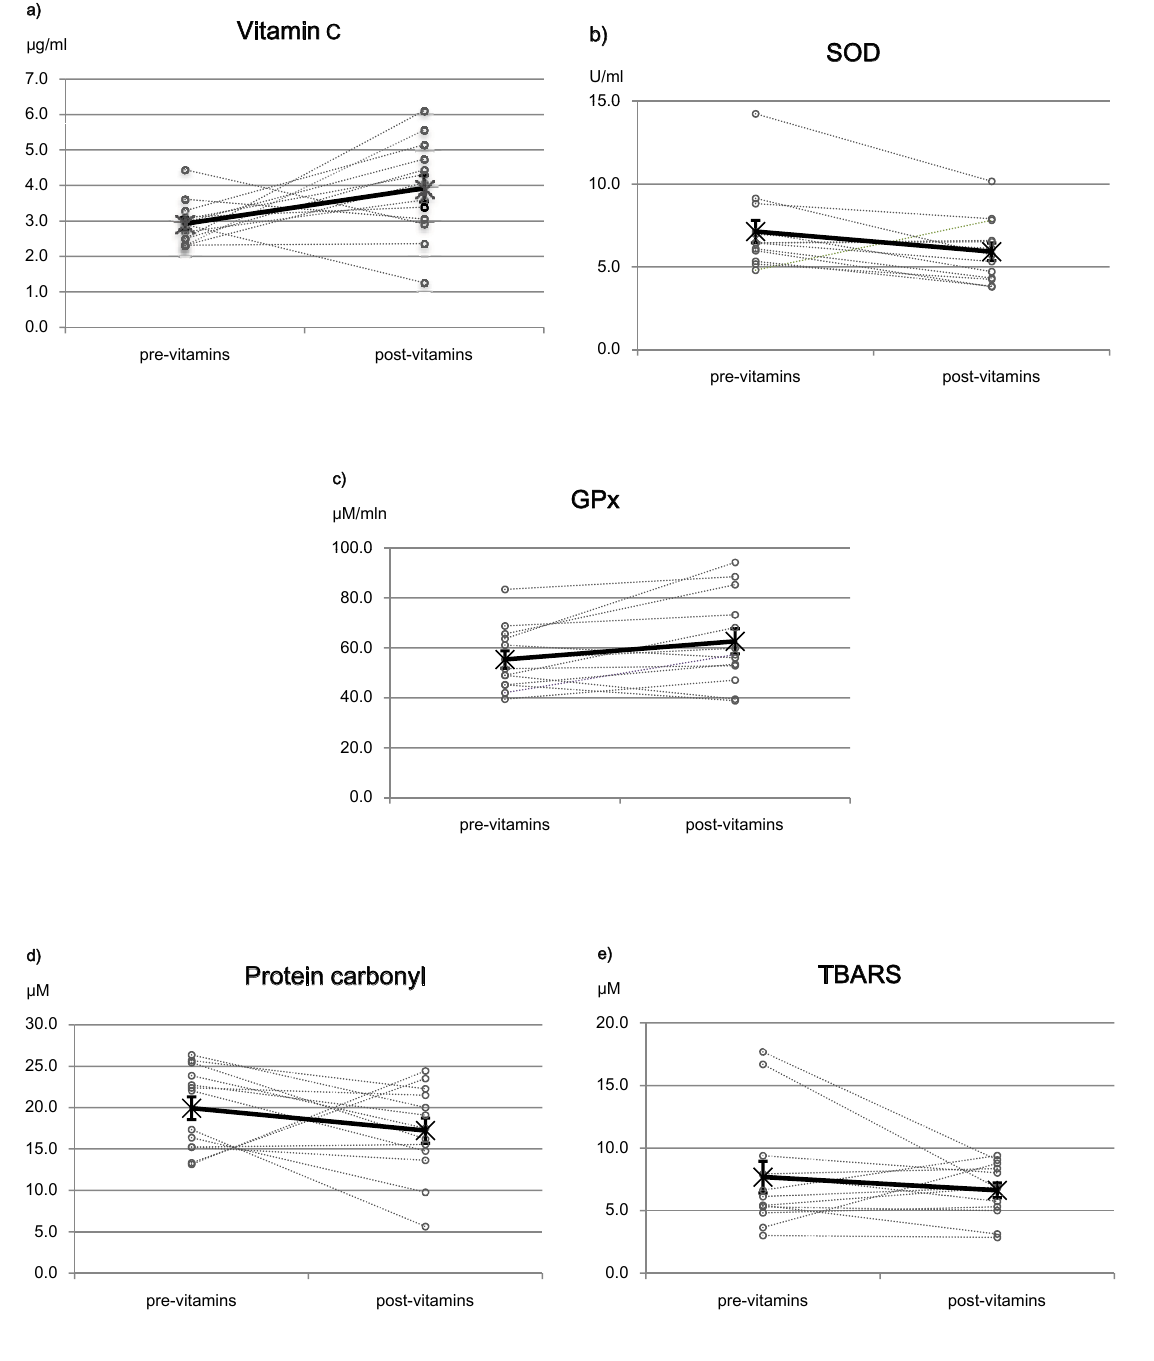
Figure 1. Plasma vitamin C concentration increased by 34% (a: p<0.05), superoxide dismutase (SOD) activity decreased by 17% (b: p<0.05), and glutathione peroxidase (GPx) activity increased by 13% (c: p<0.05) after vitamin administration. Protein carbonyl (d) and thiobarbi- turic acid-reactive substance (TBARS; e) contents were similar pre- and post-vitamin administration. Dotted lines indicate values of each subjects and solid line indicates means ±